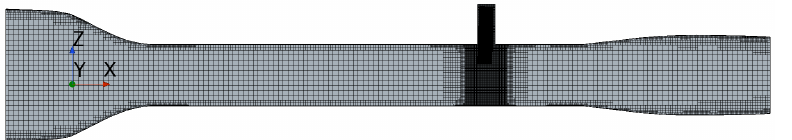
Figure 19. The structure of the mesh for the whole cavitation tunnel domain illustrating the refinement zones near the foil.